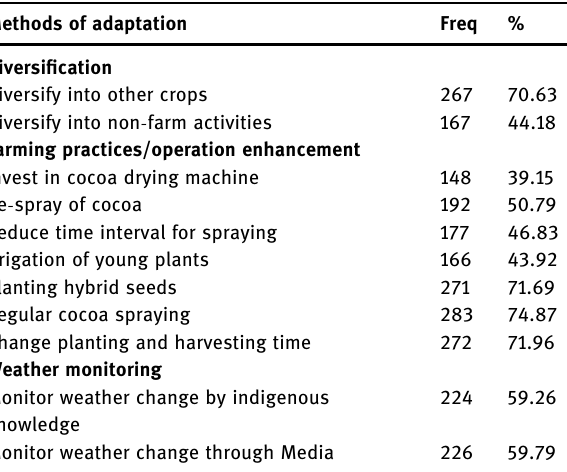
Table 4: Adaptation measures employed by cocoa farmers against climate change Methods of adaptation